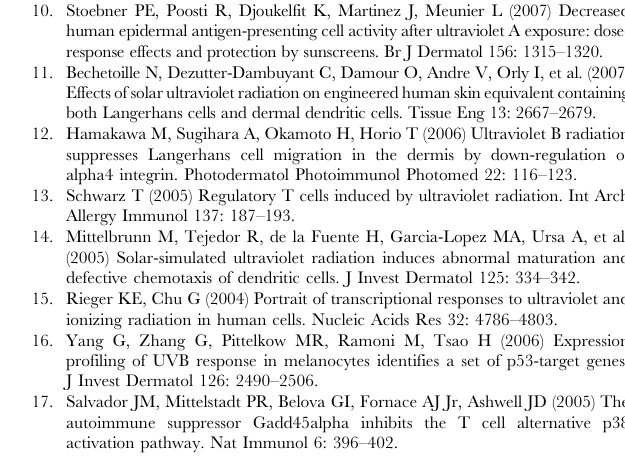
Table S2 Gene Sets enriched during UVA + UVB irradiated human DCs according to GSEA. A. Gene Sets (Up-regulated). B. Gene Sets